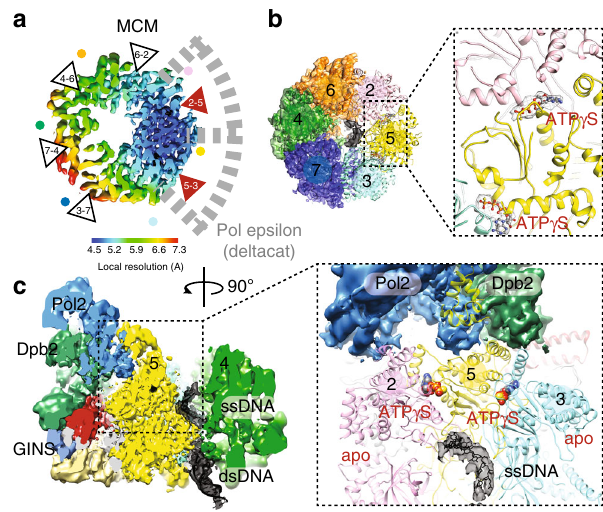
Fig. 5 ATPase state and DNA binding in the CMG-Pol epsilon complex. a Inspection of the local resolution map indicates that the ATPase site clamped by C-Pol2/Dpb2 is highly stable, with the Mcm5 AAA + module reaching resolutions as high as 4.5 Å. b Single-stranded DNA is captured by ATPase pore loops of Mcm3, -5, -2, and -6. ATP γ S is bound to the Mcm5-3 and Mcm2-5 subunits. c A cut-through view of the CMG-Pol epsilon reveals duplex DNA entering through the N-terminal domain of MCM and the leading-strand template captured within the ATPase domain. A 90° rotated view of the Mcm3-5-2 region reveals how C-Pol2/Dpb2 clamping stabilizes nucleotide binding and single-stranded DNA engagement by Mcm2, Mcm5 and Mcm3 pore